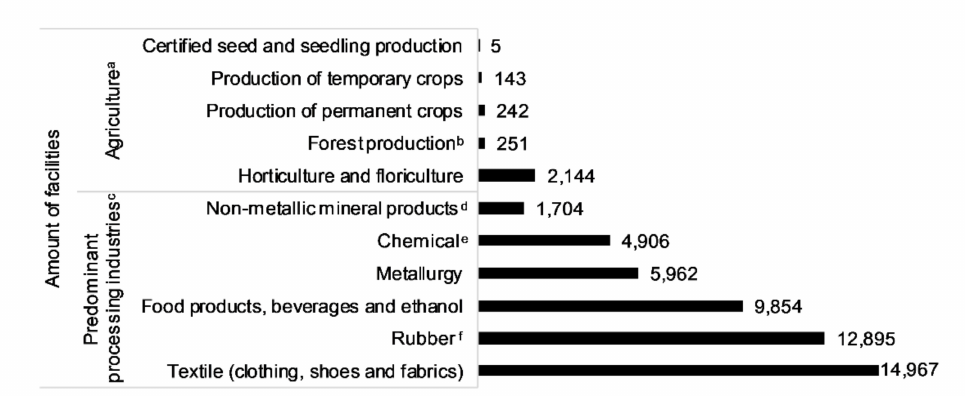
Figure 4. Predominance of agricultural and industrial activities in the surrounding area of the wastewater treatment plant. Notes: (a) Based on the Brazilian Institute of Geography and Statistics (IBGE) [38]; data refer to 2017; (b) it includes planted and native forests; (c) based on [39]; data refer to January to September of 2019; the automobile sector is not included. Other sectors were not included because they are not highlighted in the Great ABC region [40]. Other sectors correspond to the mechanical industry; electrical and communications industry; transport material industry; wood and furniture industry; paper, cardboard, editorial, and graphic industry; and footwear industry (23,390 facilities in total); (d) manufacturing of materials such as cement; (e) industries such as pharmaceutical, veterinary, perfumery, and others; (f) smoke, leather, fur, and similar